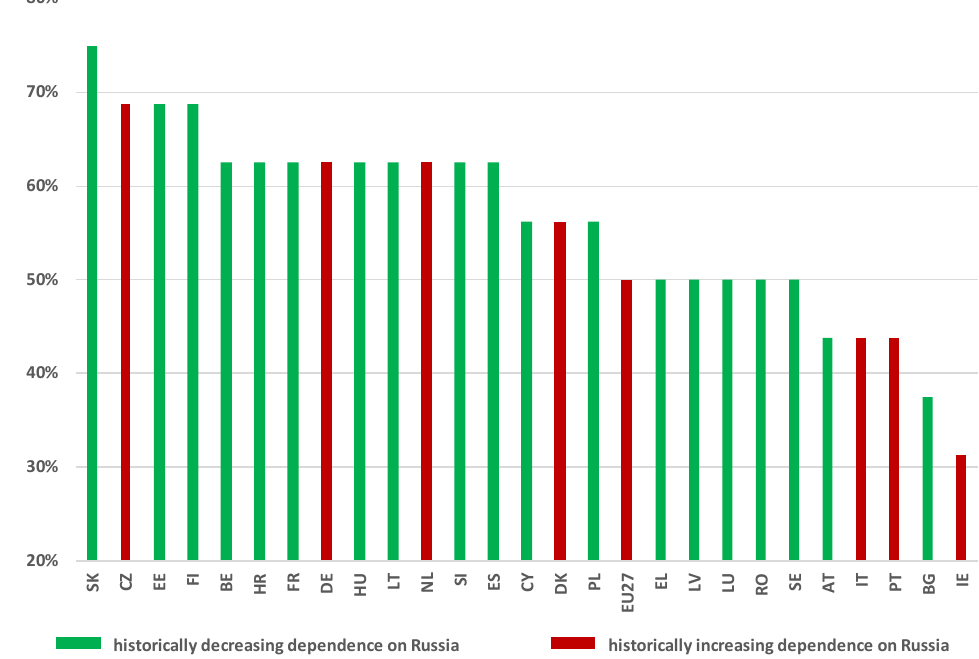
Table 4. Multiple linear regression model analysis in respect of DRs dynamics.